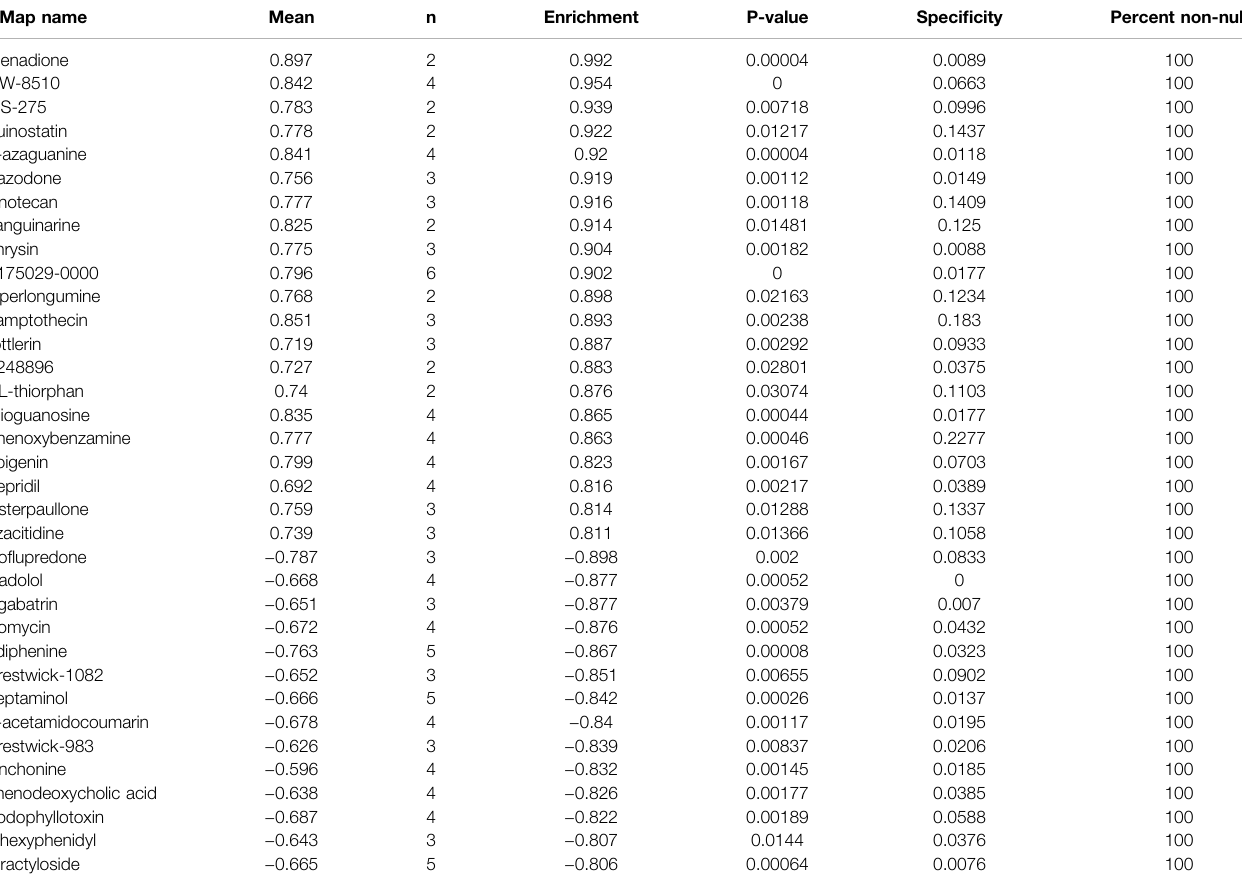
TABLE 2 | Potential small molecular agents against rectal cancer by CMap analysis. CMap